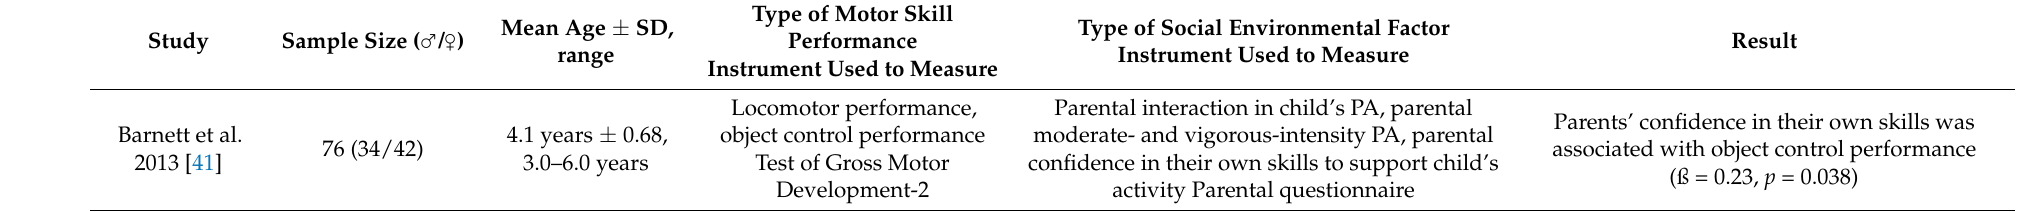
Table 1. Overview of the included